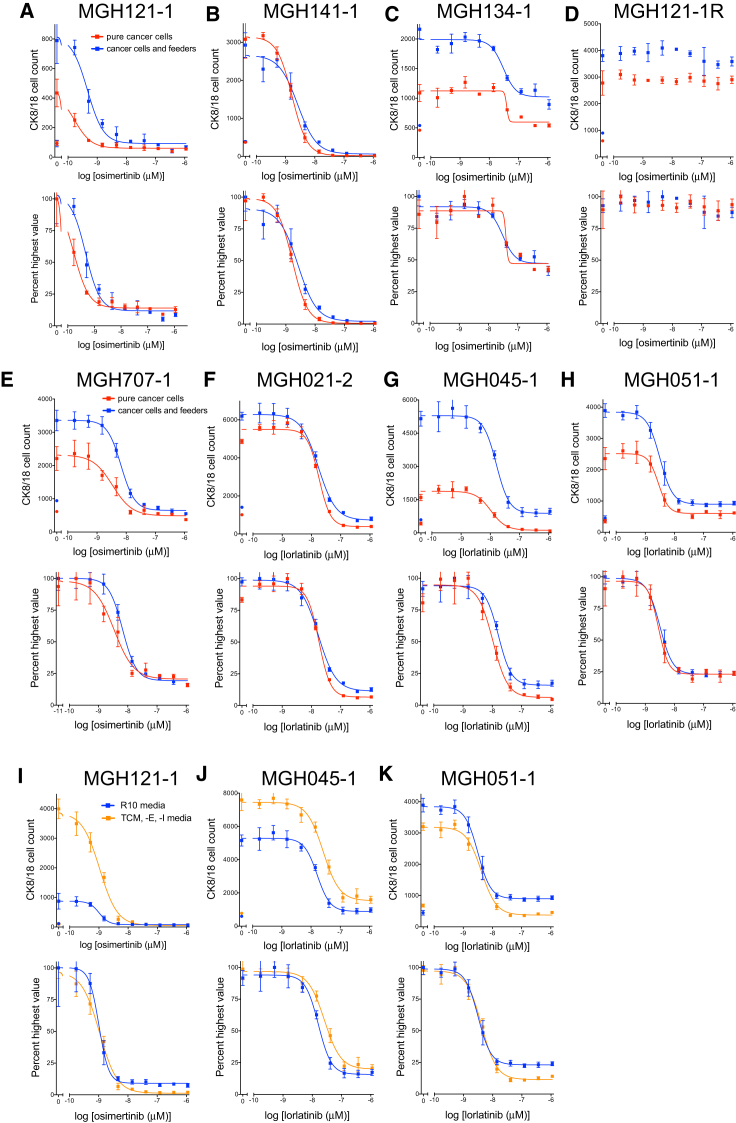
Sensitivity of EGFR Mutant and ALK-Translocated Lung Cancer Cells to EGFR or ALK Inhibitors, Respectively, Growing Alone or in the Presence of Irradiated Human Foreskin Fibroblasts and in R10 or TCM, -E, -I Media(A–H) Patient-derived EGFR-mutant (A–E) or ALK-translocated (F–H) lung cancer cells growing alone (red curves) or in the presence of irradiated human foreskin fibroblasts (blue curves) in 384-well plates in R10 or D10 media were treated with nine doses of the EGFR inhibitor osimertinib or the ALK inhibitor lorlatinib for 4–7 days. (A) MGH121-1. (B) MGH141-1. (C) MGH134-1. (D) MGH121-1R. (E) MGH707-1. (F) MGH021-2. (G) MGH045-1. (H) MGH051-1. (MGH121-1R cells were made resistant in vitro to the third-generation EGFR inhibitor WZ4002 by increasing its concentration over time.)(I–K) Patient-derived EGFR-mutant (I, MGH121-1) or ALK-translocated (J and K, MGH045-1 and MGH051-1, respectively) lung cancer cells growing in R10 media (blue curves) or in TCM, -E, -I media (orange curves) in the presence of irradiated feeder fibroblasts in 384-well plates were treated with nine doses of the EGFR inhibitor osimertinib or the ALK inhibitor lorlatinib for 4–7 days. Plates were fixed and stained with Hoechst 33342 and the anti-CK8/18 antibody to determine the change in CK8/18-positive cells. Raw CK8/18 cell counts are illustrated on the top graphs, and normalized values (percent highest) are depicted on the bottom. Circles indicate CK8/18-positive cell number at day of treatment initiation.Nonlinear regression curves fit to the data points are shown, and data are represented as mean ± SD with n = 4 replicates and experiments performed twice. See also Figure S2.